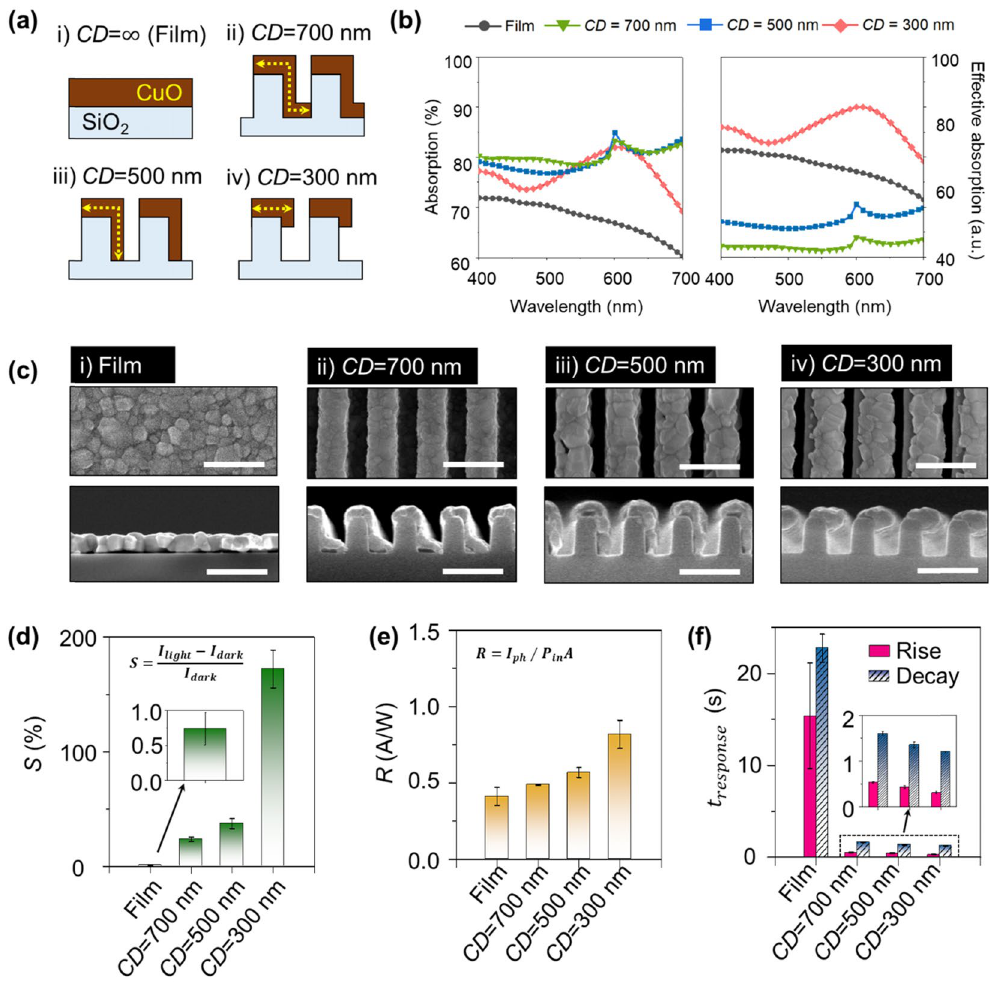
Figure 4. Performance comparison of various device shapes with different critical dimensions ( CD ). ( a ) Top (upper panel) and cross-sectional (lower panel) SEM image of various fabricated CuO shapes. ( b ) Calculated absorption of NW array with different CDs . (left panel: calculated value, right panel: normalized value using unit volume of CuO). ( c ) Fabricated CuO film and CuO NWs with different CDs (upper panel: top view, lower panel: cross-sectional view/scale bar 500 nm). Calculated optoelectrical results in comparison to different CuO nanostructures having different CD, ( d ) sensitivity ( S ), e) photo-responsivity ( R ), and ( f ) response time of the fabricated samples. All data are calculated from the optoelectronic response for P light = 22.5 μW/cm 2